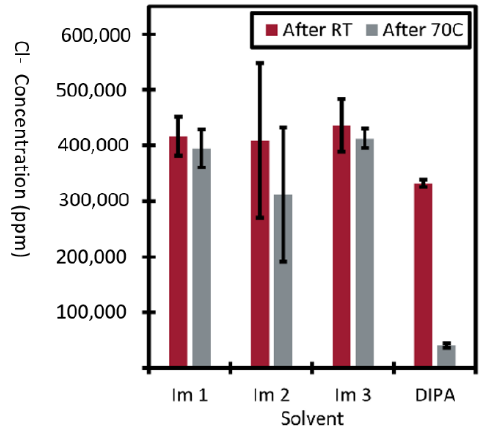
Figure 2. The average amounts of Cl − ion concentration that was in the water phase after contact with the solvent at RT and after release from the solvent at 70 °C. The error bars represent one standard deviation among at least two trials.